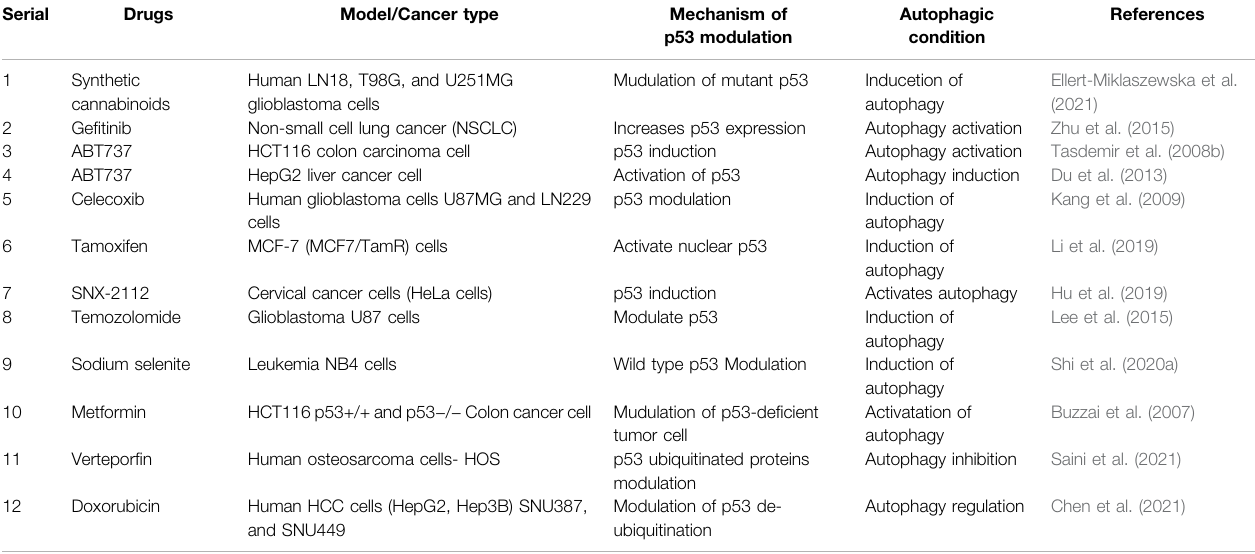
TABLE 1 | Several therapeutic drugs targeting p53-mediated autophagy regulation in cancer therapy.